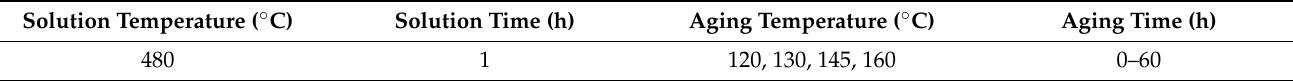
Table 2. The plan of the heat treatment process.